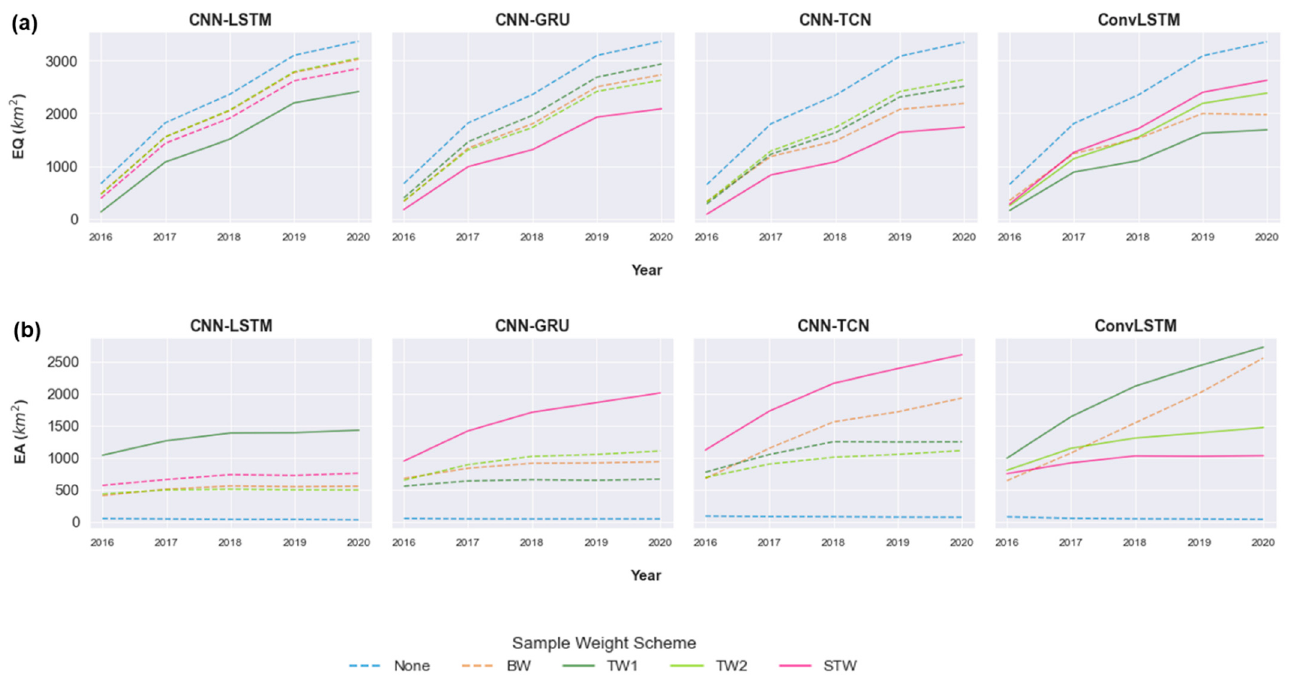
Figure 7. Cumulative errors from 2016 to 2020 for ( a ) error due to quantity (EQ) and ( b ) error due to allocation (EA). The model and sample weight combinations with the top six FOM values for the 2016 forecast are indicated by bold lines.